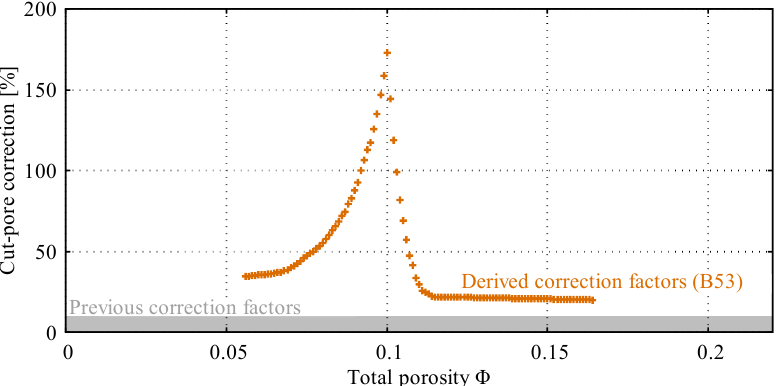
Figure 4. Necessary correction factors for the cut-pore effect assuming the B53 core would have been analyzed with the method used for Summit, Greenland (Schwander et al., 1993). The range of corrections applied in previous literature is indicated by the gray